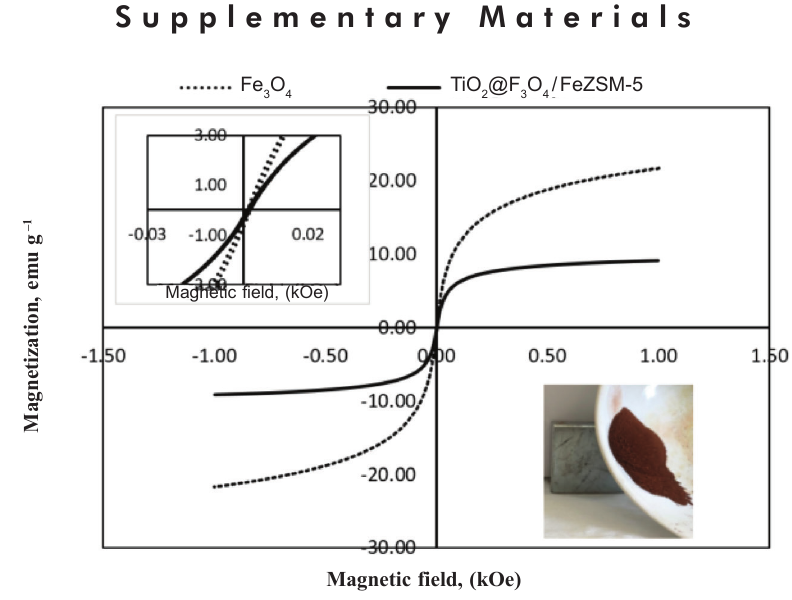
Fig. 1 S – VSM analysis of prepared catalysts